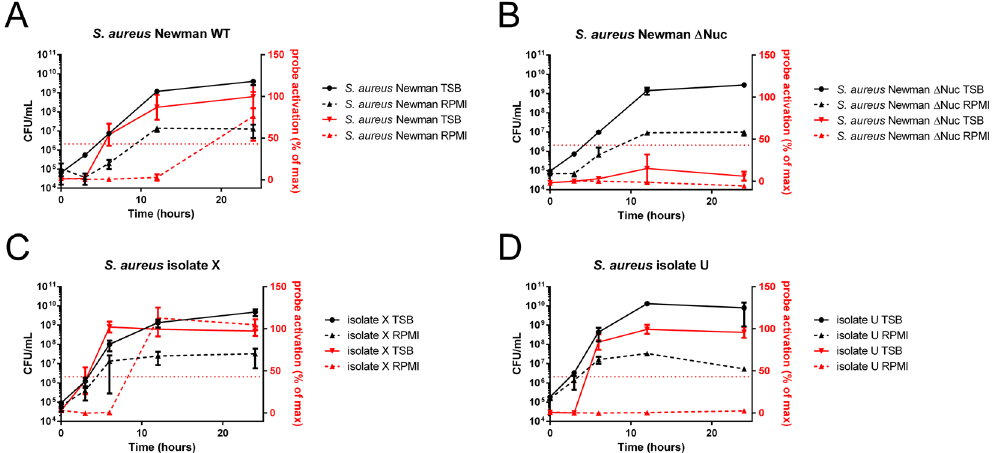
Figure 4. Activation of the P2&3 TT-probe by S . aureus grown to different stages in TSB and RPMI. Left Y-axis and lines in black indicate CFU per mL, right Y-axis and lines in red indicate probe activation as a percentage of the maximum activation. All experiments were done in triplicate, and the plots present the average numbers of the measurements. Capped lines indicate standard deviation. Strains included were: A, S . aureus Newman wild- type; B, nuclease deficient S . aureus mutant ( Δ nuc ); C, S . aureus clinical isolate X 29 ; and D, S . aureus clinical isolate U 29